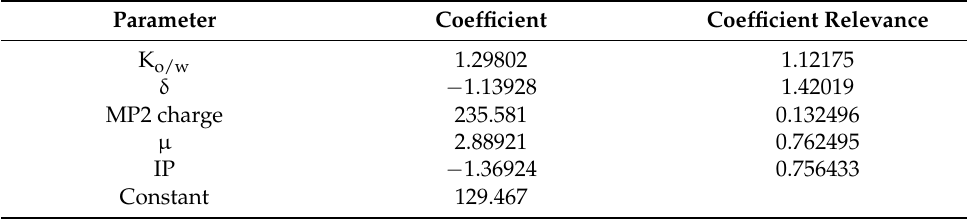
Table 2. Parameter